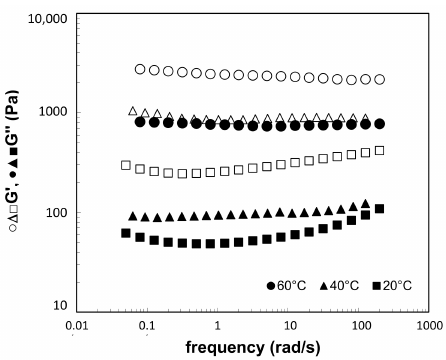
Figure 12. Dependence of dynamic moduli G (cid:48) and G (cid:48)(cid:48) on the frequency of oscillation in the range of linear viscoelastic response for gels, formed at 60 ◦ C, 40 ◦ C and 20 ◦ C, respectively. Solid symbols represent viscous modulus G”, hollow symbols represent elastic modulus